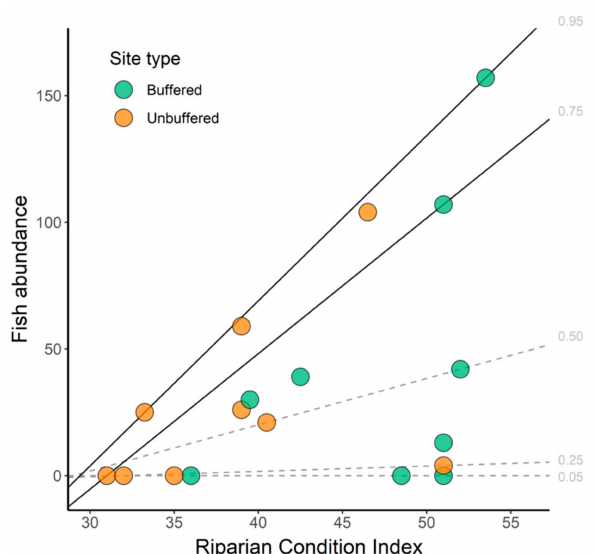
Figure 3. Slopes from estimated quantile regression coefficients for the 0.05, 0.25, 0.50, 0.75, and 0.95 percentiles. Solid lines indicate significant relationships ( p < 0.05), whereas dashed lines indicate non-significant relationships ( p < 0.05). The results show a “wedge-shaped” pattern of variation in fish abundances relative to the Riparian condition Index (RCI), where good riparian condition places an upper constraint on fish numbers, but other factors limit fish densities, even with good riparian